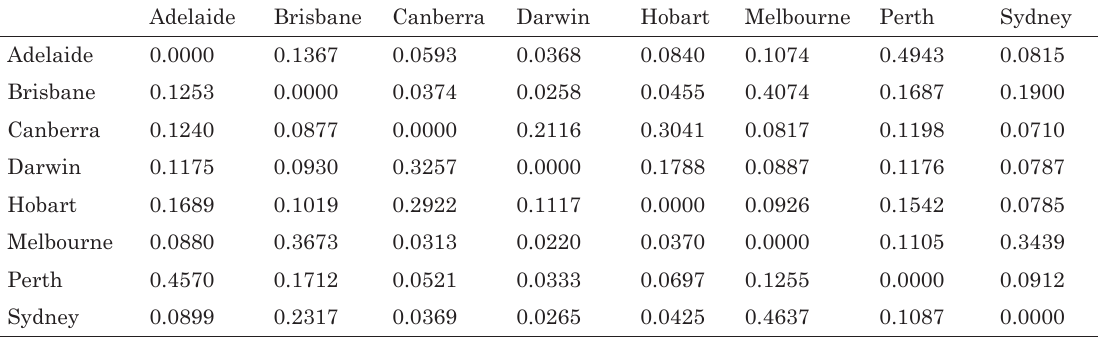
Table 3. Average demographical spatial